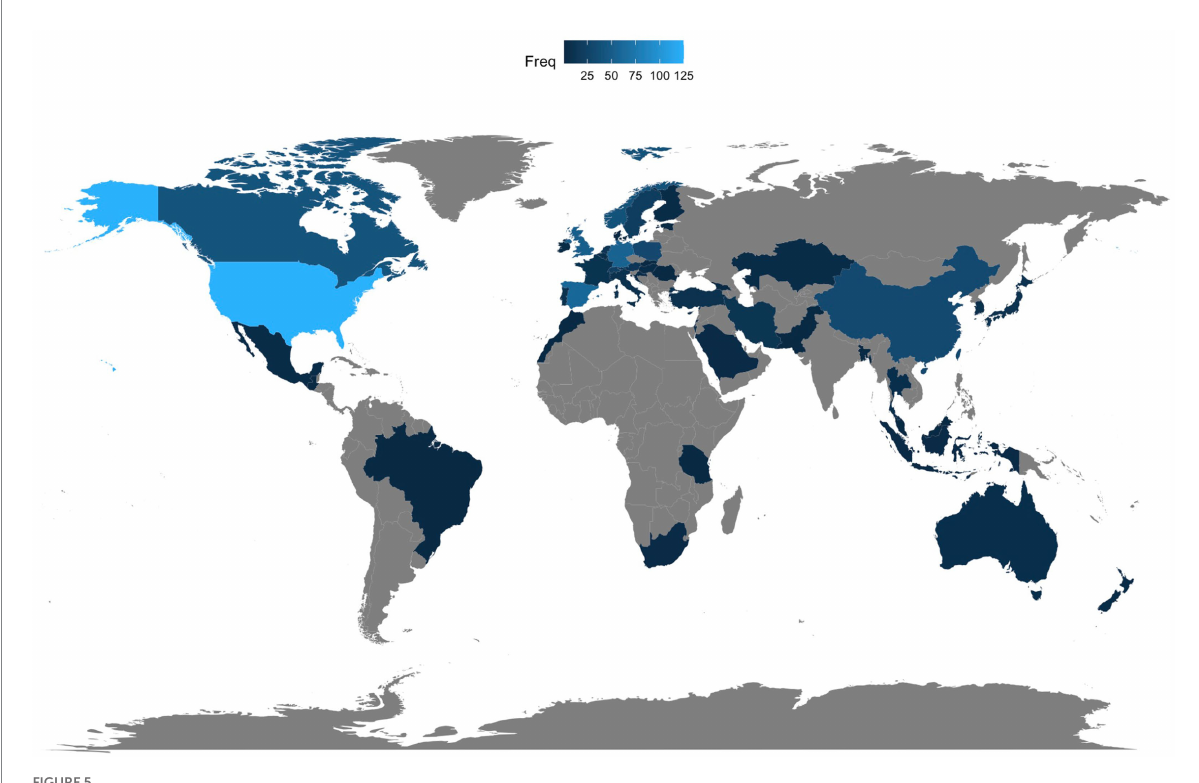
FIGURE 5 Scientific production by country. Different shades of blue indicate different productivity rates: grey indicates no contribution, and dark blue stands for high productivity. Freq denotes the